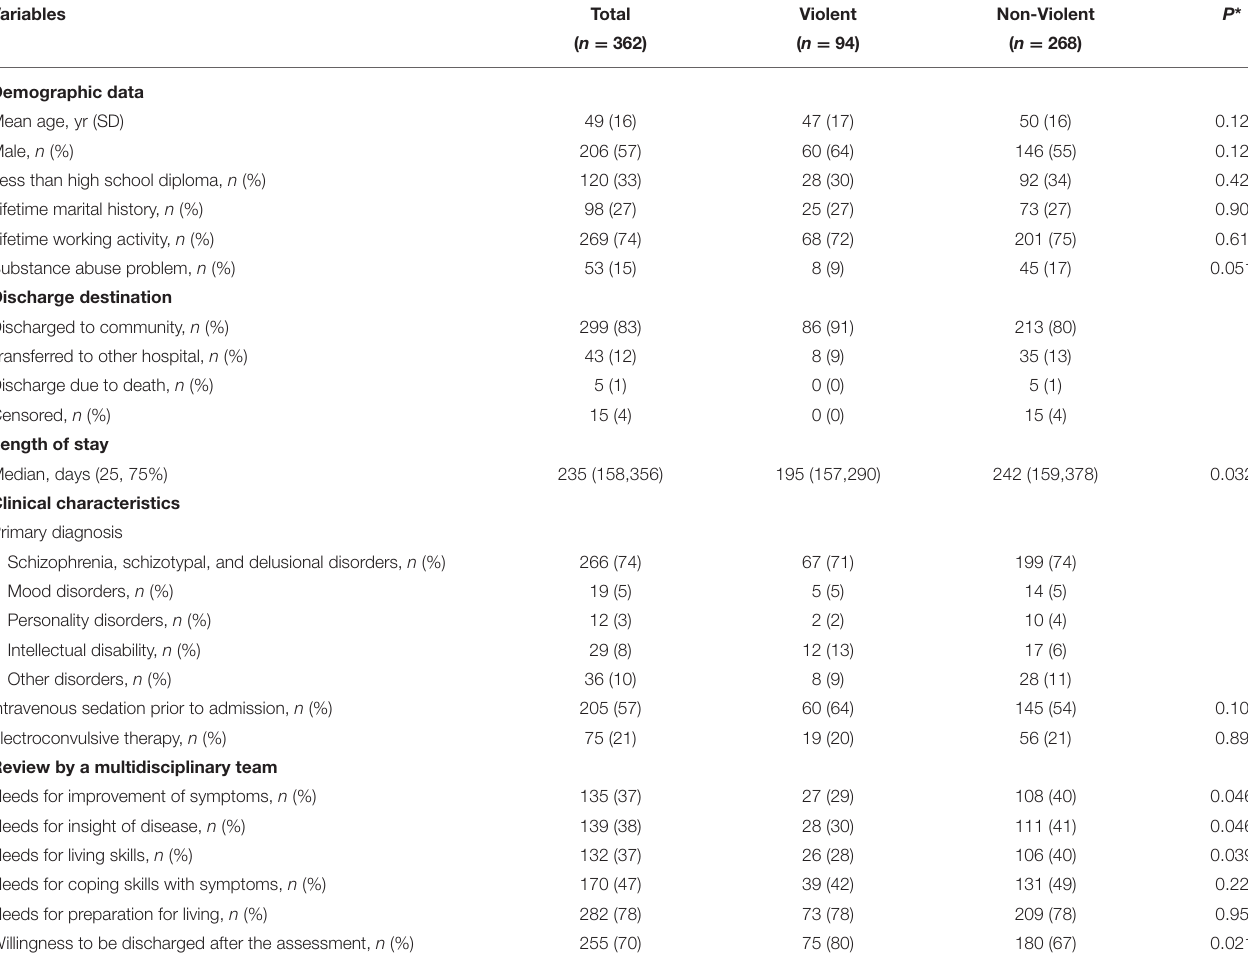
TABLE 1 | Characteristics of the participants according to the presentation of violent behavior that led to the current admission.